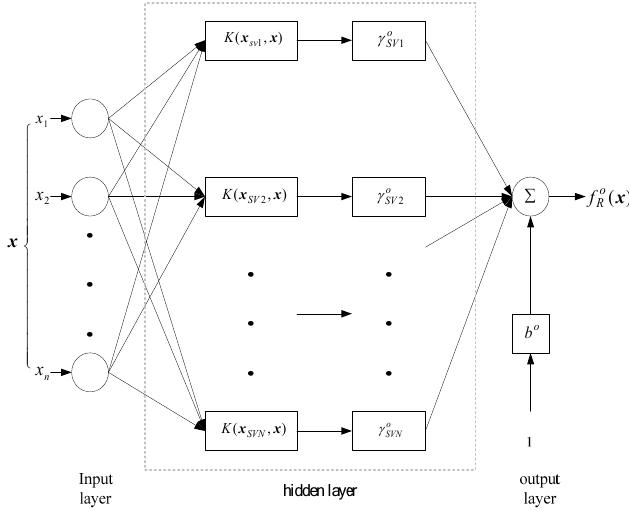
Figure 2. Structure of the SVR network.